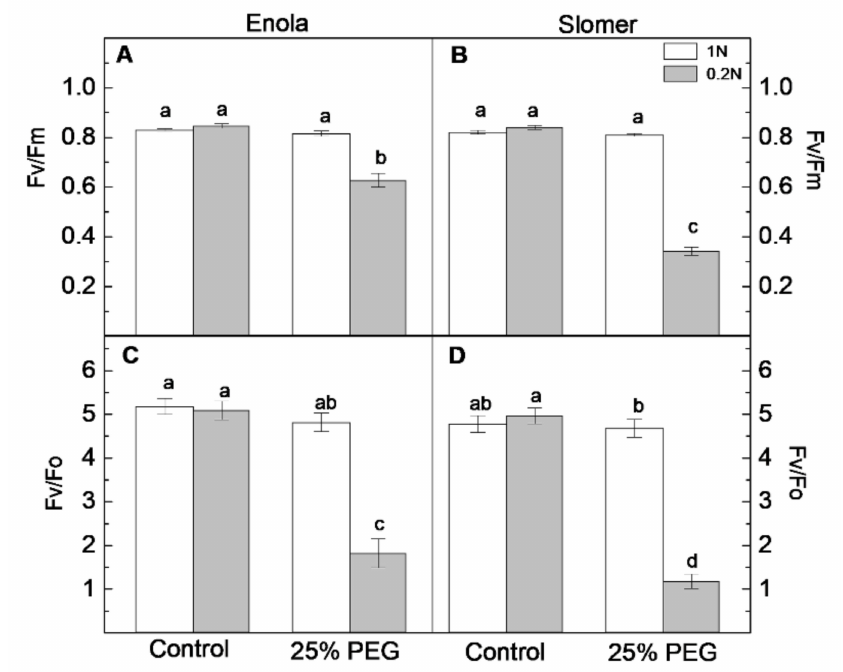
Figure 6. Chlorophyll fluorescence parameters: ( A , B ) maximum quantum efficiency of photosystem II (PSII) (F v /F m ) and ( C , D ) potential photosynthetic activity (F v /F 0 ), measured in leaves of two wheat cultivars (Enola and Slomer) grown on optimal (1 N) and reduced (0.2 N) nitrogen supply and subjected to osmotic stress with 25% PEG. Different letters represent significant differences at p < 0.05 ( n =